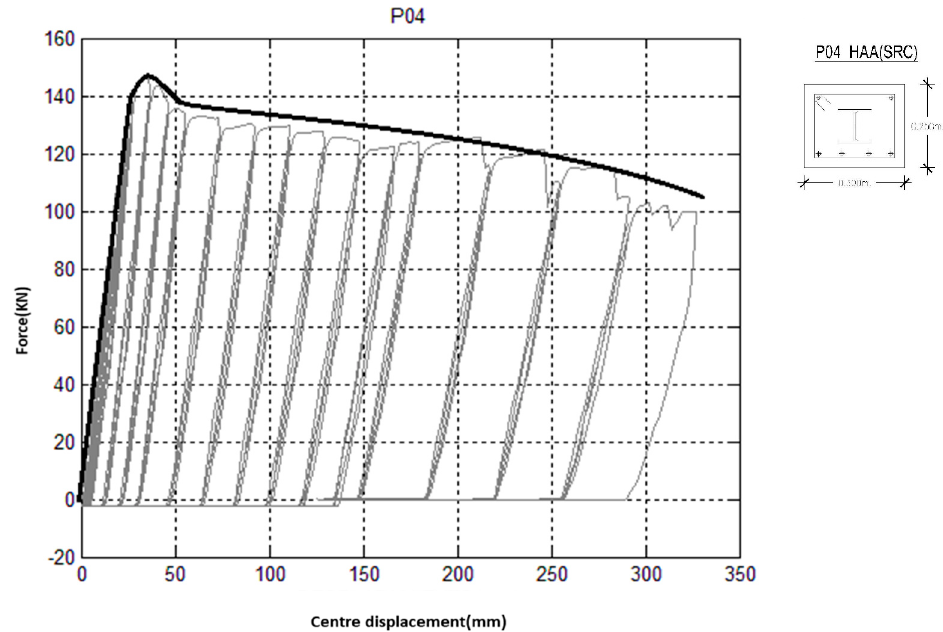
Figure 23. Force–displacement graph of the experimental results of P04.